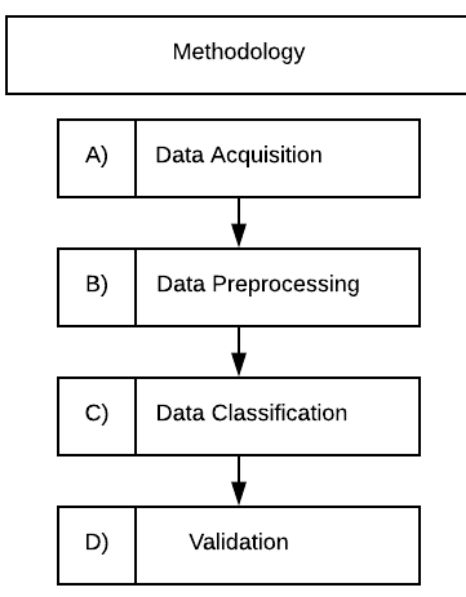
Figure 1. Flowchart of the methodology